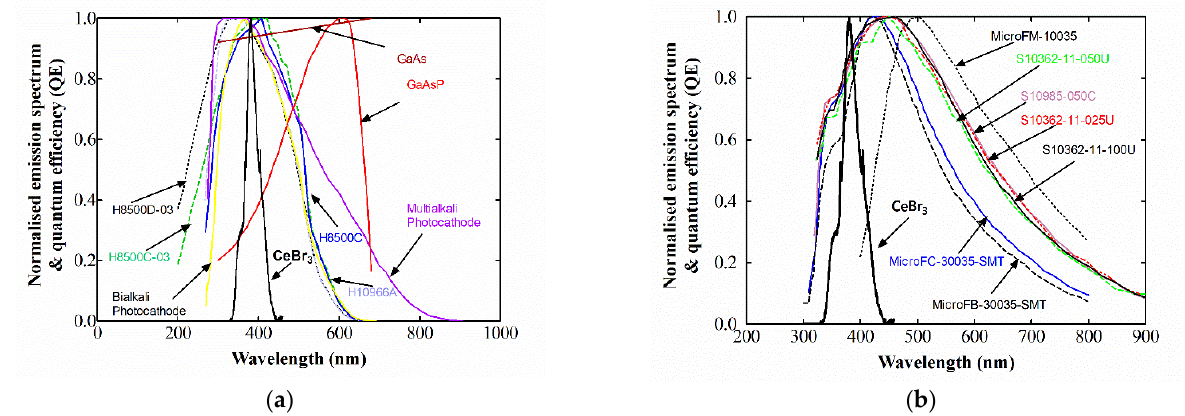
Figure 3. CeBr 3 spectral matching with: ( a ) photocathodes; ( b ) silicon photomultipliers.